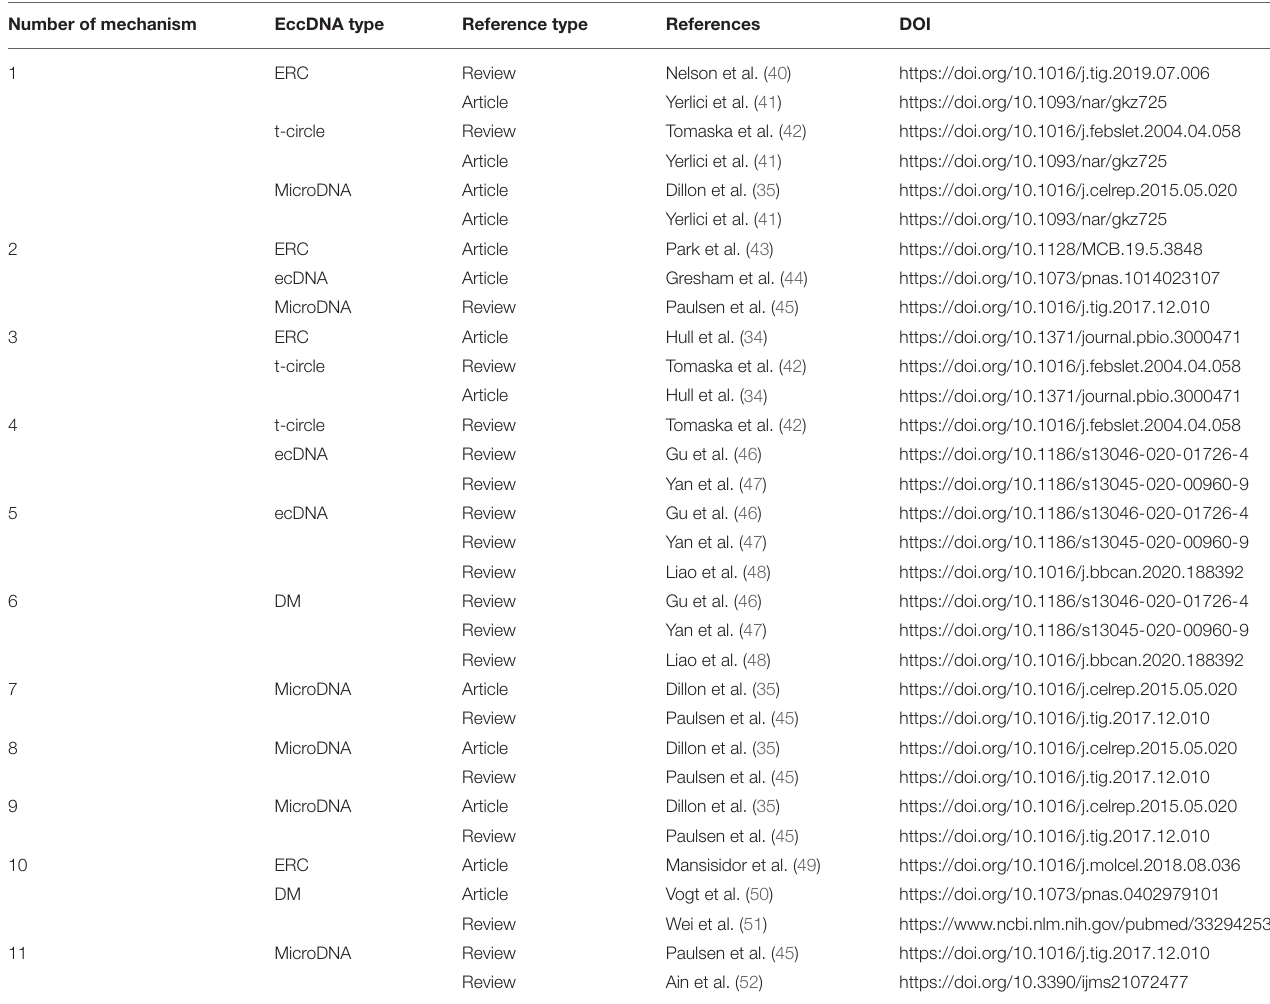
TABLE 1 | Potential mechanisms of eccDNA formation and corresponding